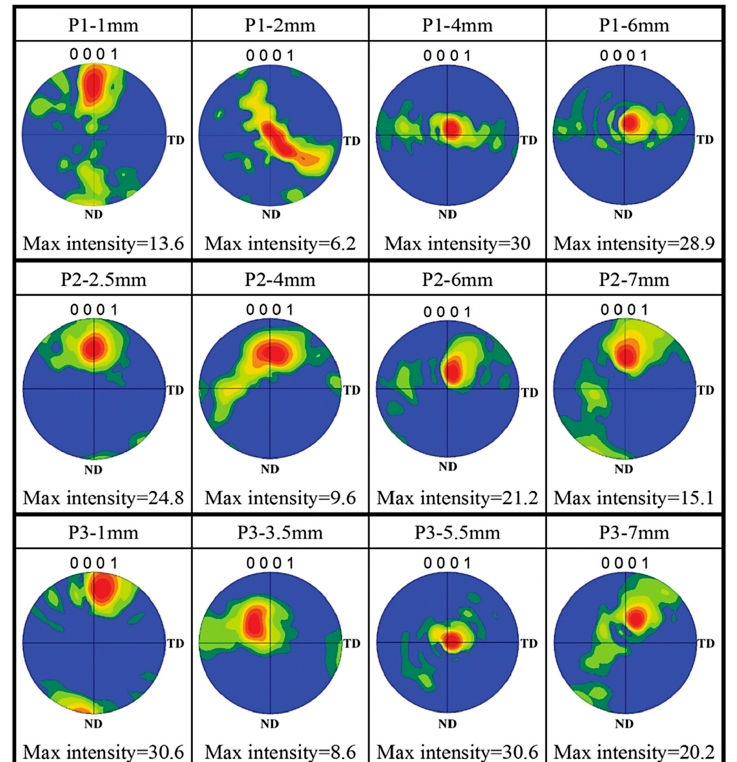
Figure 14. Pole figures of (0001) derived from EBSD for various locations on the cross-sections of NZ30K alloy friction stir processed in different rotation speeds and processing speeds [19]. (Reprinted with permission from ref. [19]. Copyright 2016 Elsevier